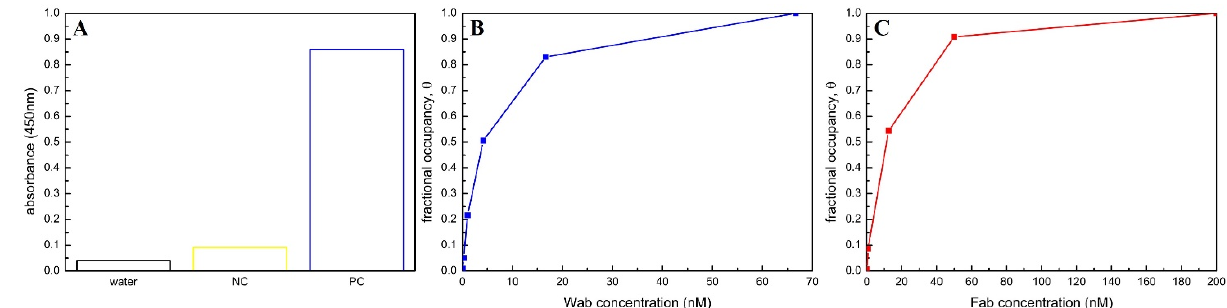
Figure 4. ( A ) Verification of immobilization method with PEG-mSAMs and target-probe binding by indirect ELISA on silica surfaces. Absorbance at 450 nm of pure water (black bar), silica sample modified with PEG-SAMs and GA but without immobilizing IgG (negative control (NC), yellow bar), silica sample prepared with IgG immobilization after modifying PEG-SAMs and GA (blue bar). ( B , C ) Plot of the concentrations (nM) of either Wab or Fab bind to IgG versus their corresponding fractional occupancy to determine affinity binding of IgG-Wab (blue curve in ( B )) and IgG-Fab (red curve in ( C